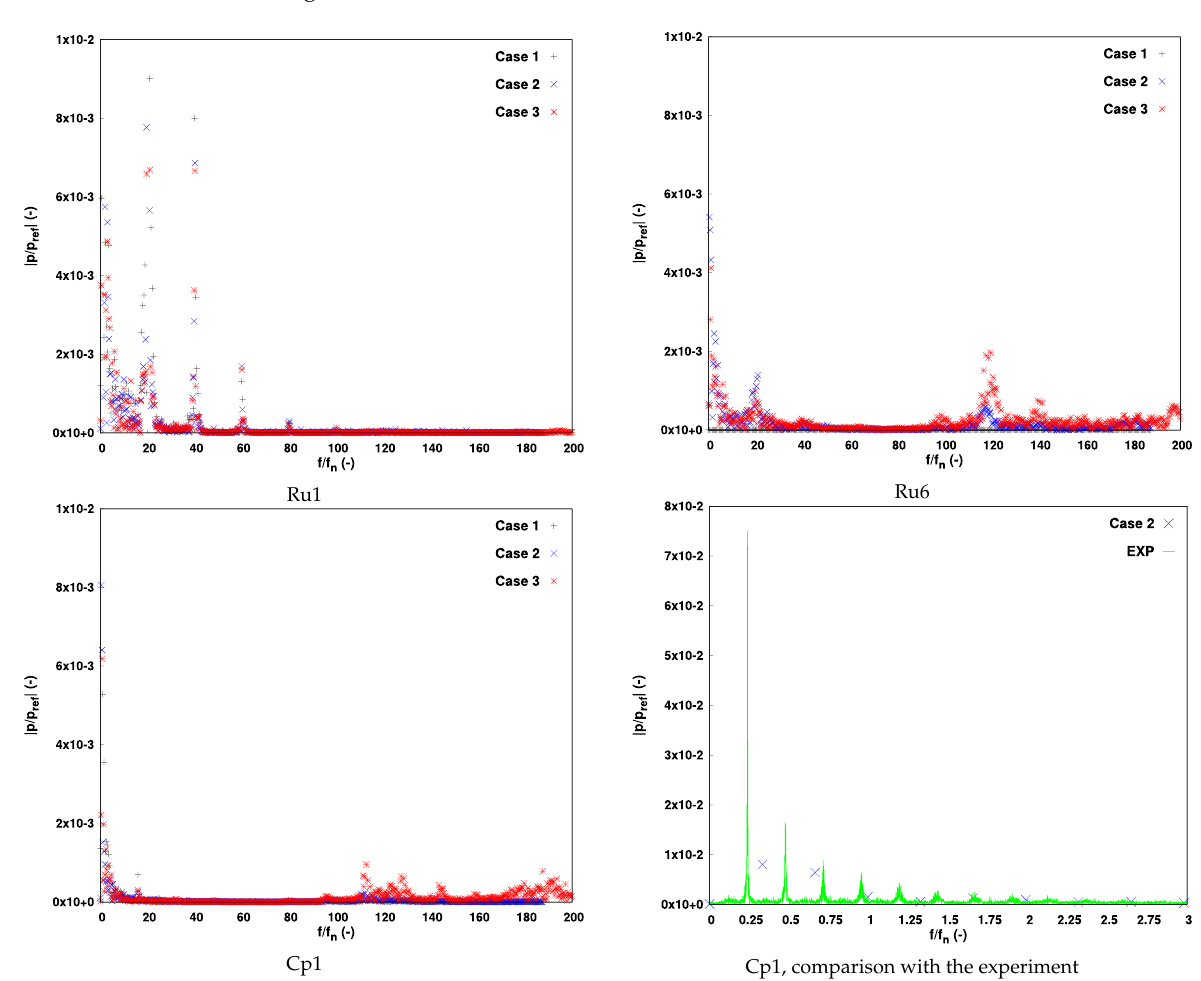
Figure 9. Magnitude of the Fourier transform of the pressure signal in the runner and the draft